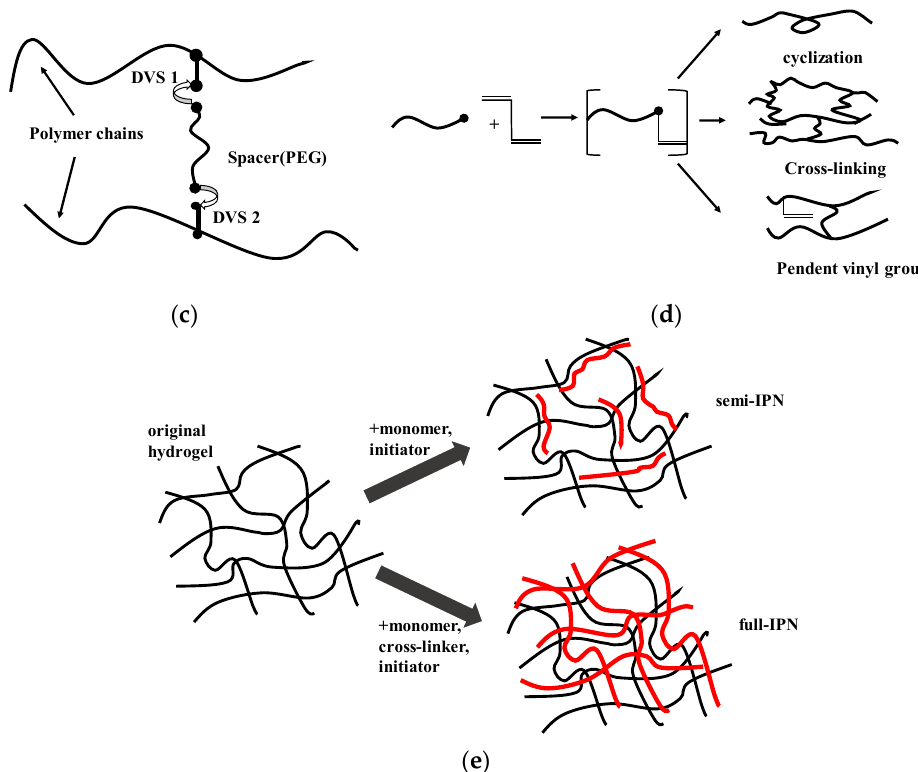
Figure 4. Formation mechanism of hydrogel. ( a ) A sketch of network formation in cellulose solutions: physical gelation via self-association of chains and chemical cross-linking; ( b ) a schematic presentation of the structures of physical and chemical cellulose gels; adapted with permission from Ref. [28] copyright 2020, MDPI. ( c ) Scheme of the crosslinking between celluloses in the presence of spacers. DVS: divinyl sulfone, cross-linked molecules. ( d ) Synthesis route of hydrogel by radical polymerization. Adapted with permission from Ref. [99] copyright 2007, Society of Chemical Industry. ( e ) Formation and structure of semi- and full interpenetrating hydrogels. Adapted with permission from Ref. [103] Copyright 2008, Elsevier